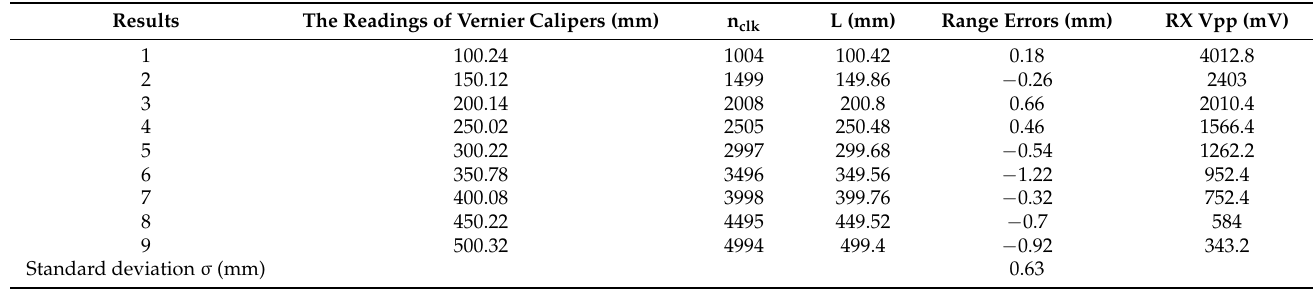
Table 1. The results of the ranging (100–500